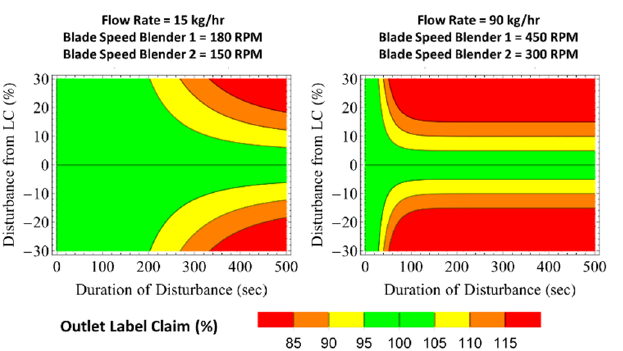
Figure 14. Funnel plots for Blender 1 + Blender 2 + feed frame at the extreme flow rate and blade speed conditions